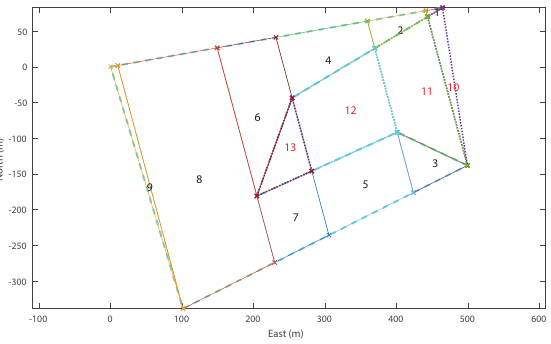
Figure 11. Full trapezoidal decomposition of ROI and optional external polygon.